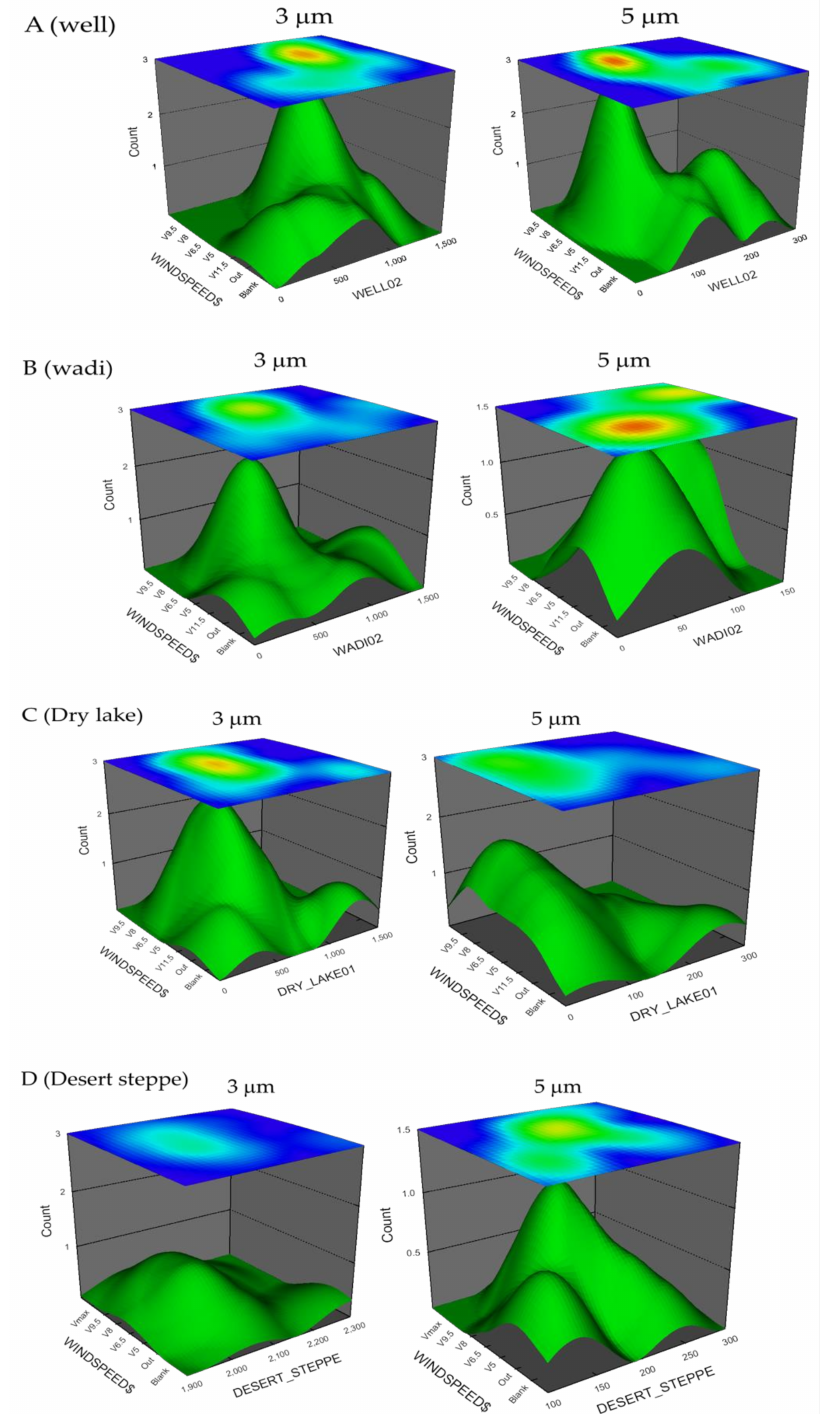
Figure 3. The particle data are analyzed by kernel density by saltation experiment. The figure shows the pattern of dust particle saltation at study sites according to the wind speed. Dust particles are more likely to saltate near the well due to overgrazing, and it can be seen that the wadi is easy to saltate in the wind because the size of the sand particles is considerably small. The measurement results at each location are shown in the particle size (3 µ m, 5 µ m), ( A ) well, ( B ) wadi, ( C ) dry lake, and ( D ) desert